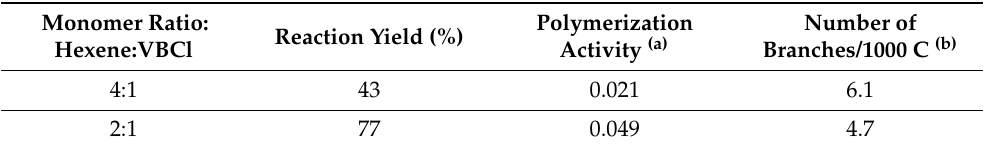
Table 1. Catalytic activity and number of branches/1000 C obtained for the synthesis of poly(VBCl- co-hexene) at 60 °C for 18 h.